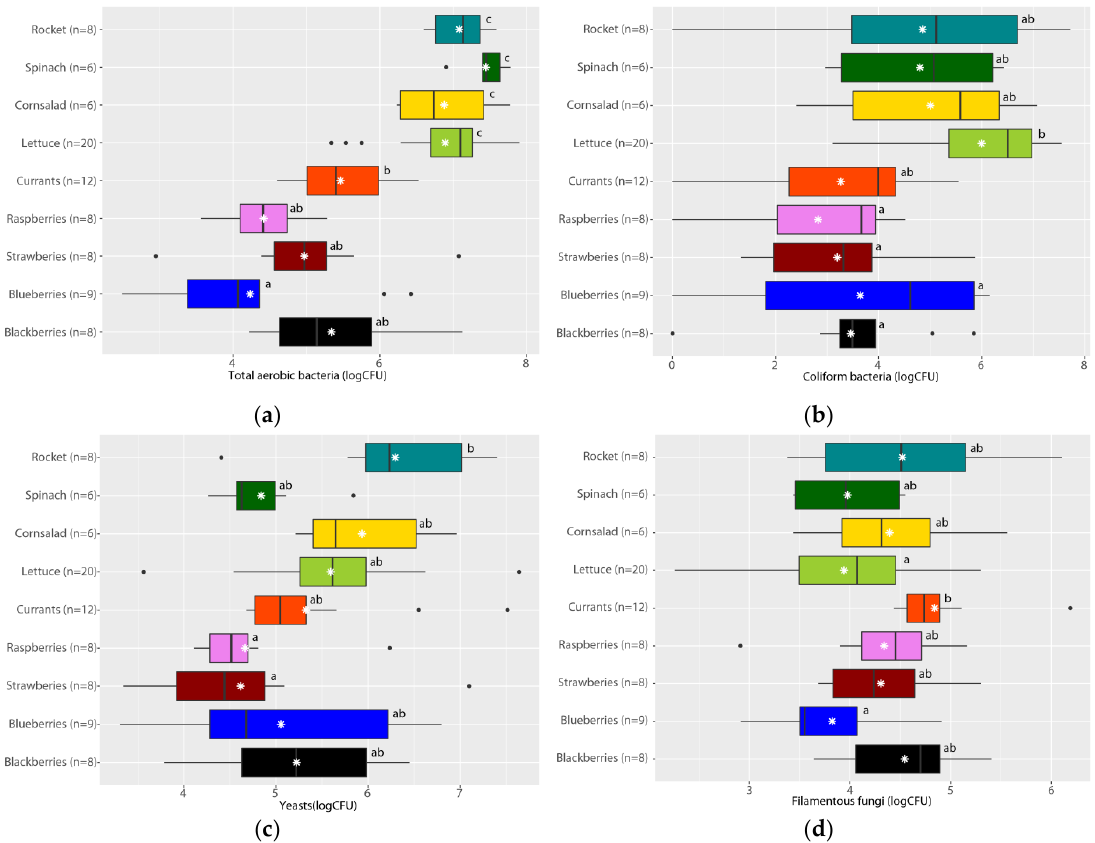
Figure 1. Boxplots of log10 (CFU.g −1 ) in samples of leafy vegetables and berry fruits. ( a ) Total aerobic counts on PCA agar; ( b ) Total coliforms on VRBL agar; ( c ) Yeasts on DRBC agar; ( d ) Filamentous fungi on DRBC agar. Box plots display the first (25%) and third (75%) quartiles, the median (horizontal line), the average (*), the maximum and minimum observed values (whiskers), and extreme values ( · ) within each data set. Boxes signed with the same letter are not significantly different according one- way ANOVAs and Tukey’s Test at α = 0.05 . Table 1. Maldi-TOF identification of non-redundant coliform isolates grown from samples of leafy vegetables and berry fruits in VRBL agar.